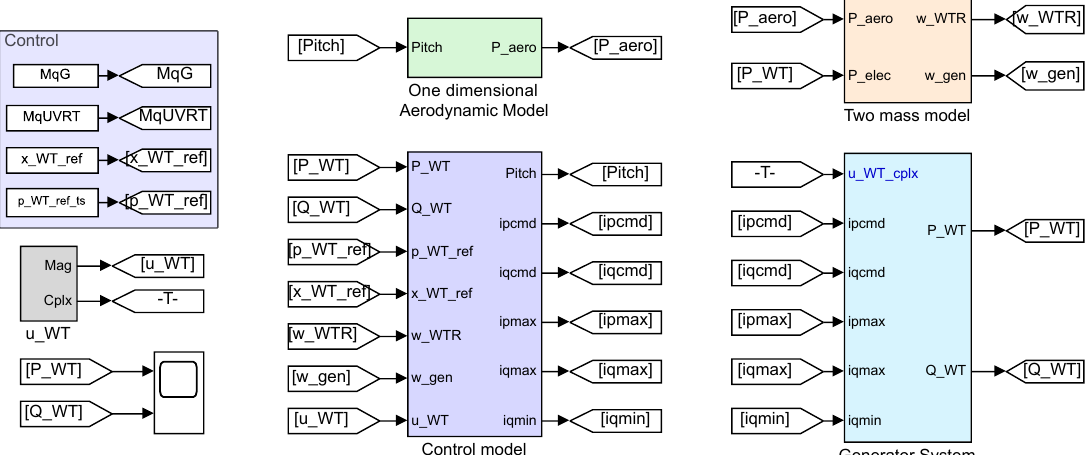
Figure 3. General structure of the IEC 61400-27-1 generic Type 3 model implemented in Simulink.